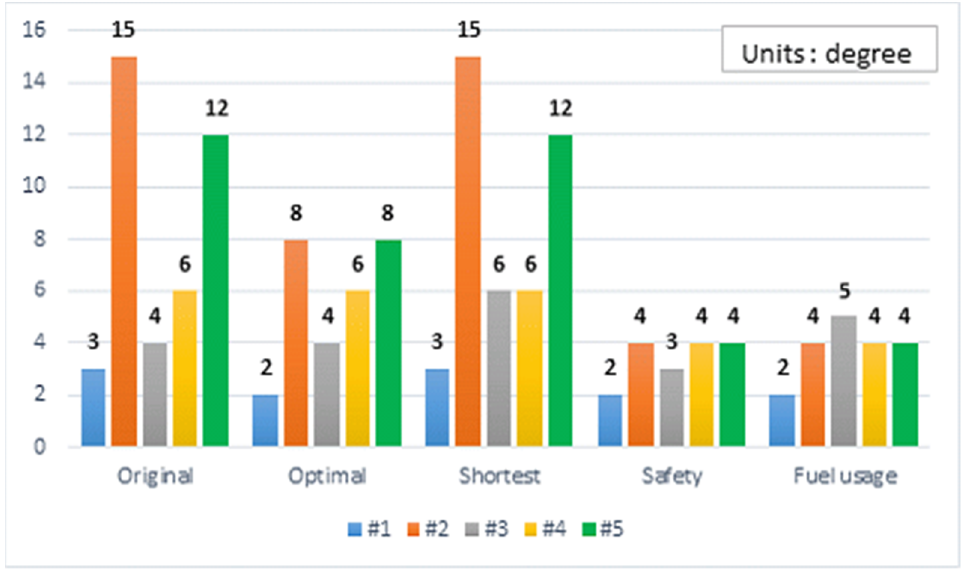
Figure 9. Compare path degree average.